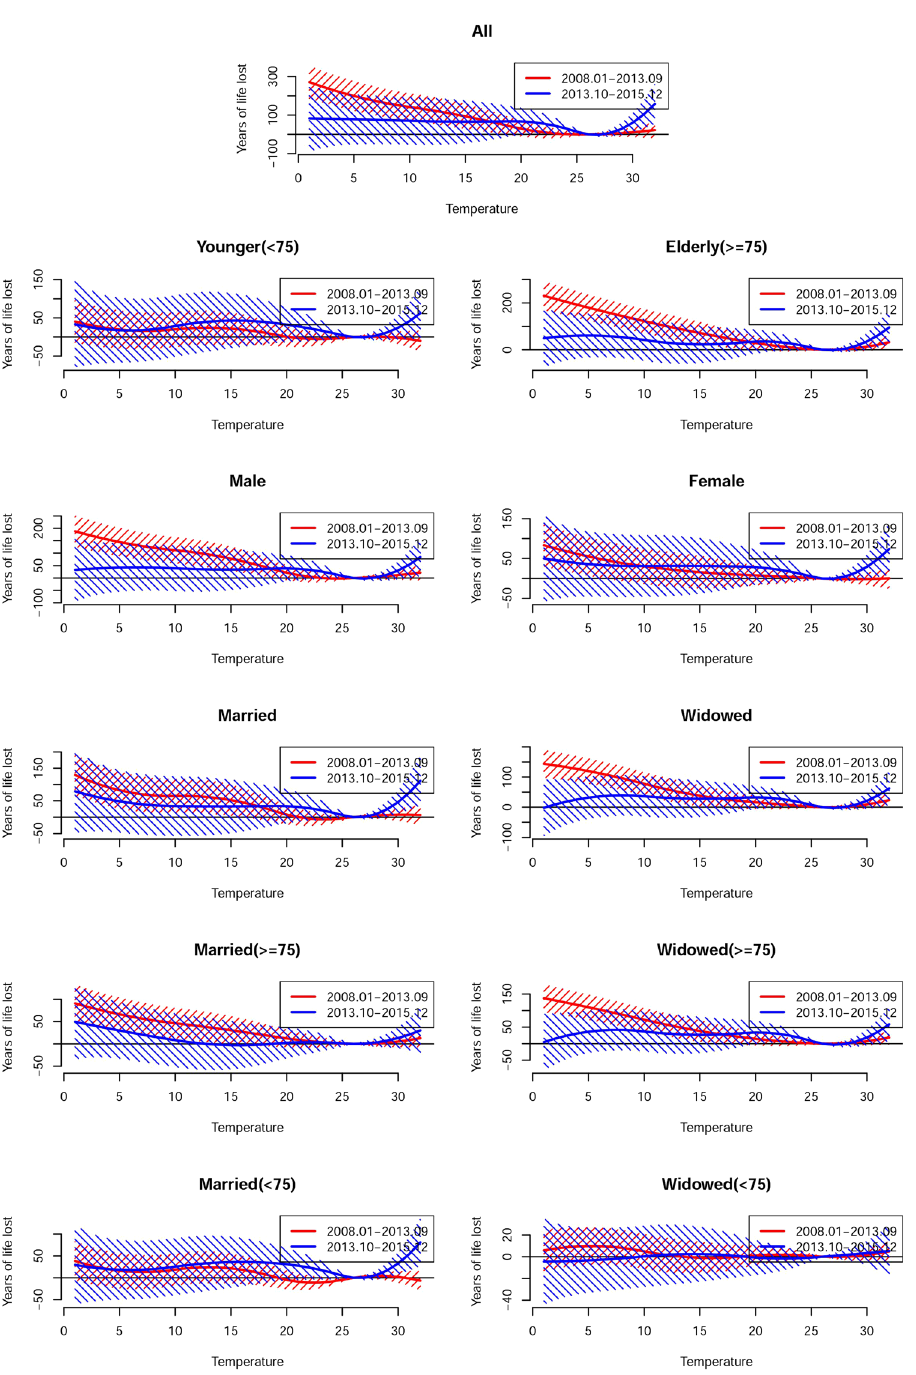
Figure 5. Overall cumulative exposure-response curves (with 95% confidence intervals) for the association between temperature and years of life lost due to respiratory mortality during period I (Jan 2008 to Sep 2013) (red) and period II (Oct 2013 to Dec 2015)